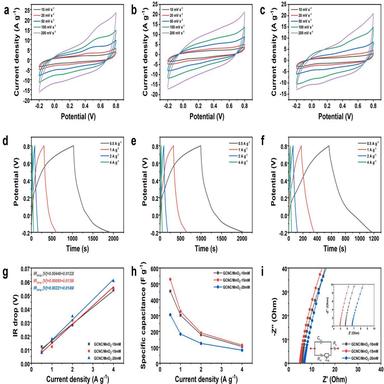
CV curves of (a) GCNC/MnO2-10 mM, (b) GCNC/MnO2-15 mM, and (c) GCNC/MnO2-20 mM at scan rates of 10–200 mV s − 1 . GCD curves of (d) GCNC/MnO2- 10 mM, (e) GCNC/MnO2-15 mM, and (f) GCNC/MnO2-20 mM at different current densities 0.5–4 A g− 1 . (g) IR drop as a function of current densities. (h) Specific capacitance of GCNC/MnO2-10 mM, GCNC/MnO2-15 mM, and GCNC/MnO2-20 mM at 0.5–4 A g− 1 . (i) Nyquist plots of GCNC/MnO2-10 mM, GCNC/MnO2-15 mM, and GCNC/MnO2-20 mM.